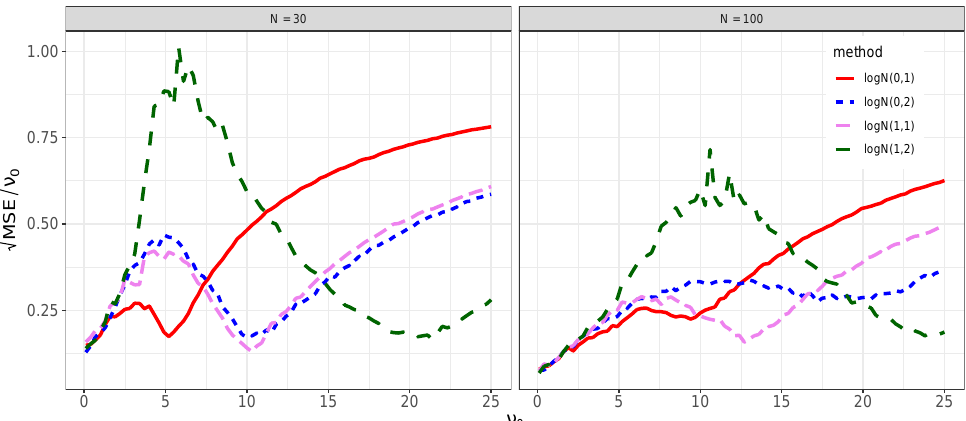
Figure 3. Frequentist properties of the posterior mean (cid:98) ν = E [ ν | x ] based on the four log-normal priors π ( ν ) = log N ( ν ; µ , σ 2 ) with ( µ , σ 2 ) ∈ { ( 0,1 ) , ( 0,2 ) , ( 1,1 ) , ( 1,2 ) } for sample sizes N = 30 and N = 100. The y -axis value is the square root of the relative MSE and the x -axis value is the true data-generating parameter on the effective support I e = ( 0,25 ) .